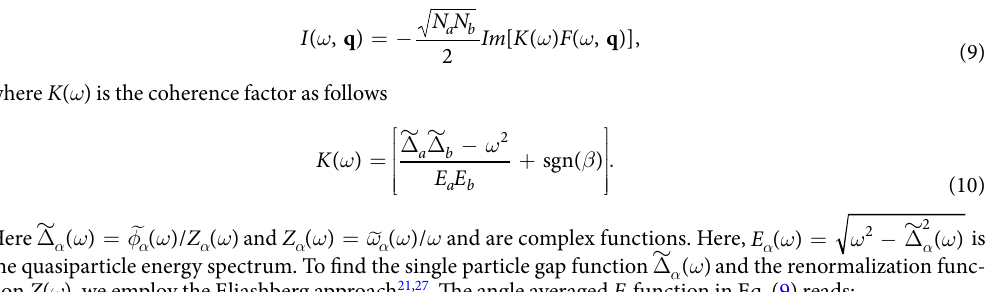
Figure 4. Evolution of momenta dependence of the QPI response function with Fermi-energy mismatch δμ = ( a ) 100, ( b ) 200 and ( c ) 500; with ε = 200 and β = − 1 at ω = Δ correspond to the s ± (left) and s ++ (right),